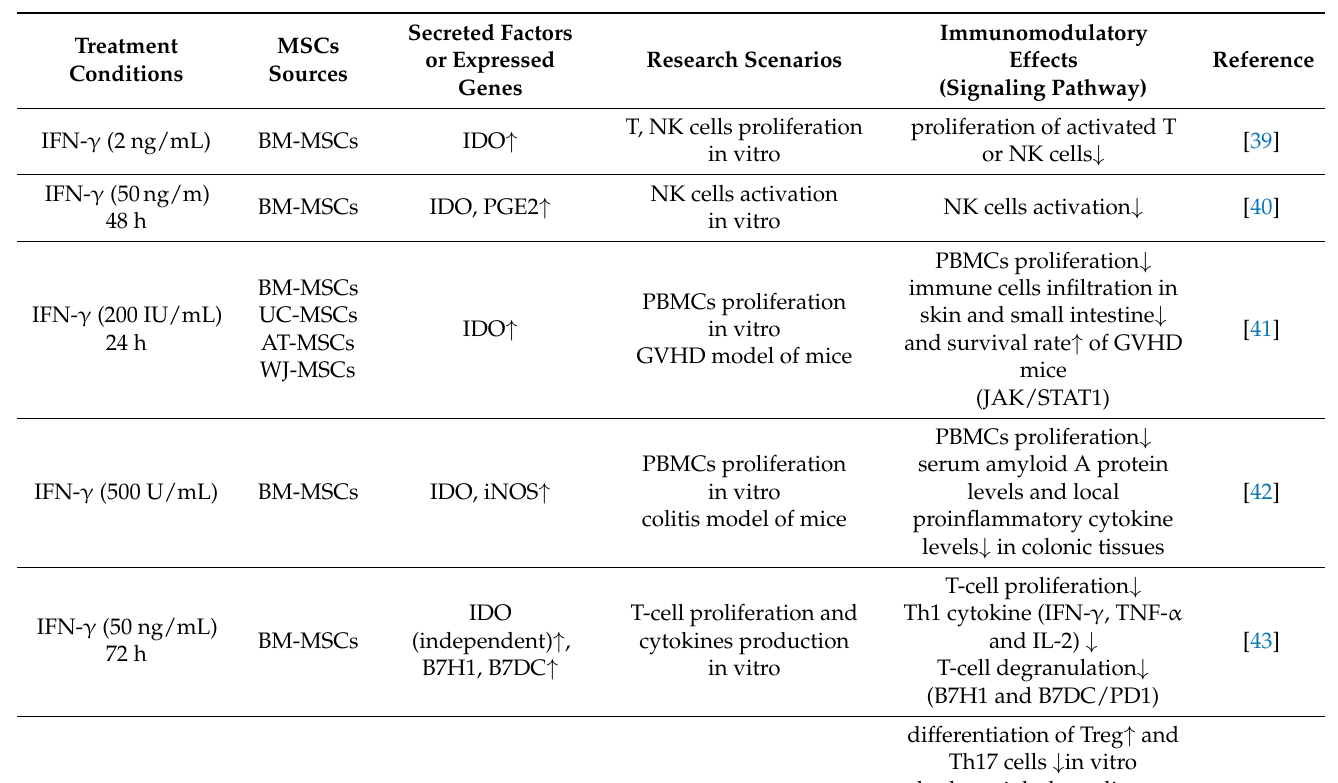
Table 2. Inflammatory factors pretreatment of